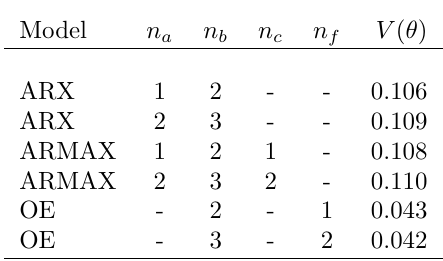
Table 2: Optimization criterion for various model structures and polynomial